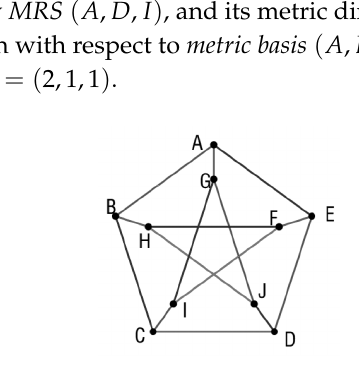
Figure 1. Metric dimension of the Petersen graph. Checking each node, we find that W = ( A , D , I ) is one possible resolving set, and no smaller resolving set exists. Hence, the metric dimension of the Petersen graph is µ ( g ) =